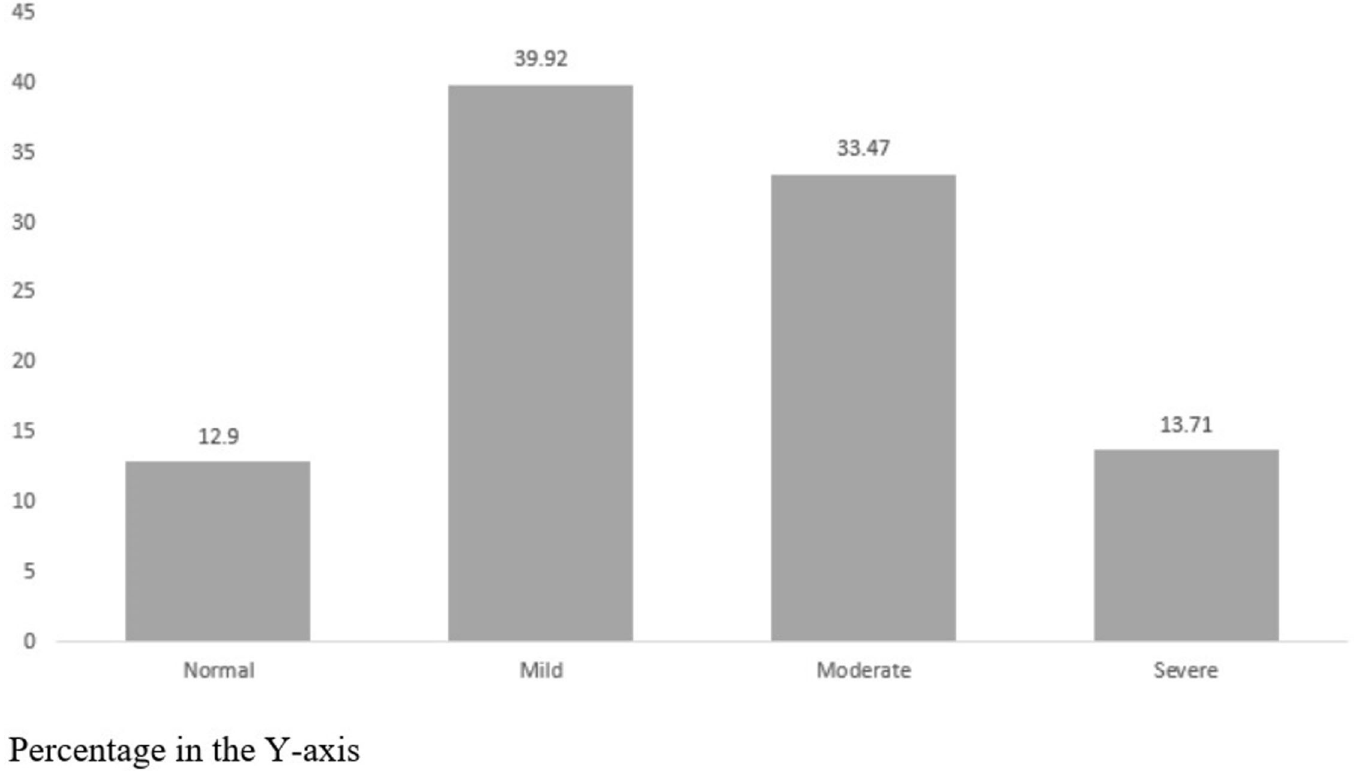
Fig 2. Frequency of symptoms and severity for levels of traumatic stress by the